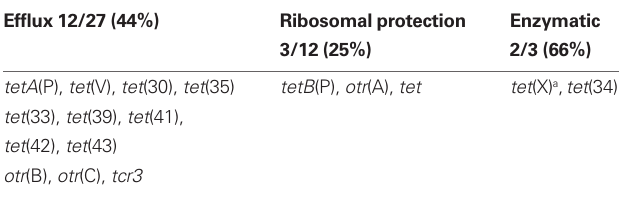
Table 4 | Tetracycline resistance genes unique to environmental